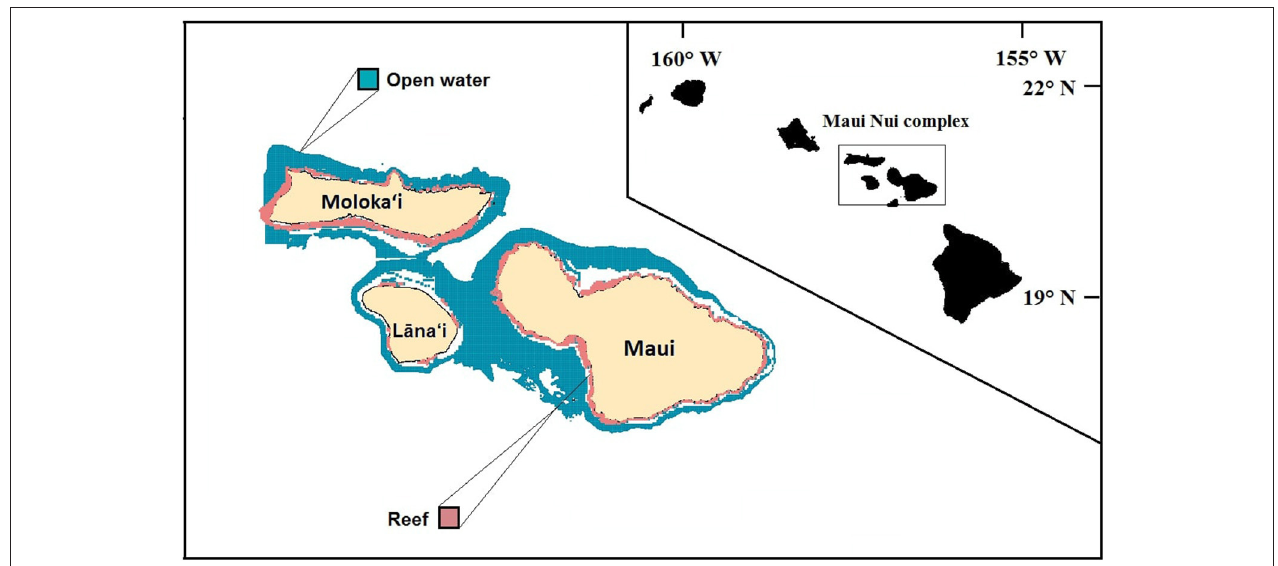
FIGURE 1 | Modeled area of the Maui Nui complex consisting of the Hawaiian Islands: Maui, Moloka‘i, and L ¯ ana‘i, with the inset figure showing the location of Maui Nui in the Hawaiian Archipelago. The pink “reef” area is the 0–30m depth range included in the model. The outer edge of open water area (blue) is defined by the 200m depth contour. White areas interior of this indicate gaps in bathymetry data.